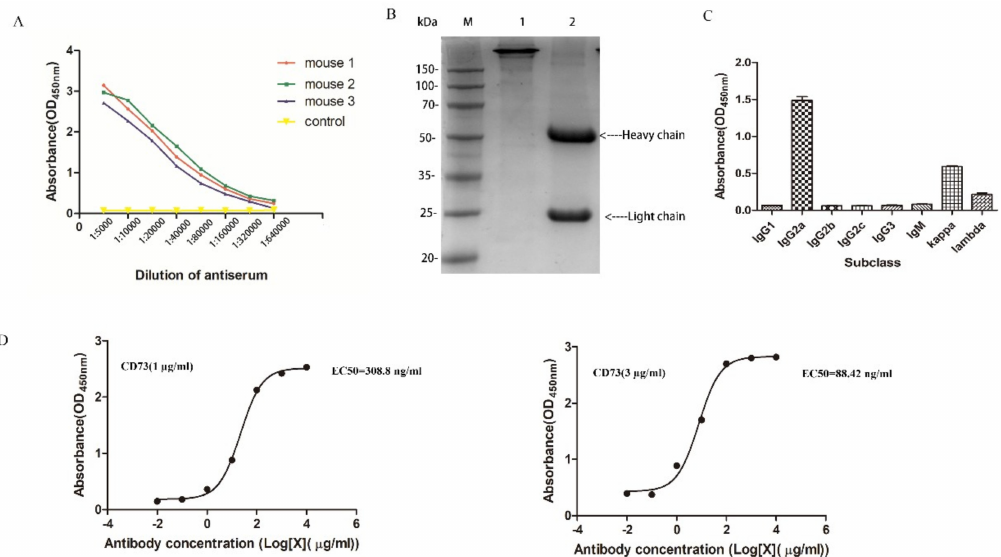
Figure 2. The characterization of CD73 mAb: ( A ) the antibody titer determination; ( B ) the SDS-PAGE analysis of the 3F7 antibody in an oxidizing and reducing loading buffer, where line 1 and line 2 were the 3F7 antibody in oxidation and reduction, respectively; ( C ) the subclass identification of 3F7; and ( D ) the binding curve of 3F7 to the CD73 protein. Left: The concentration of the coated CD73 was 1 µ g/mL. Right: The concentration of the coated CD73 was 3 µ g/mL. Data are representative of at least three independent experiments and means ± SD were presented.